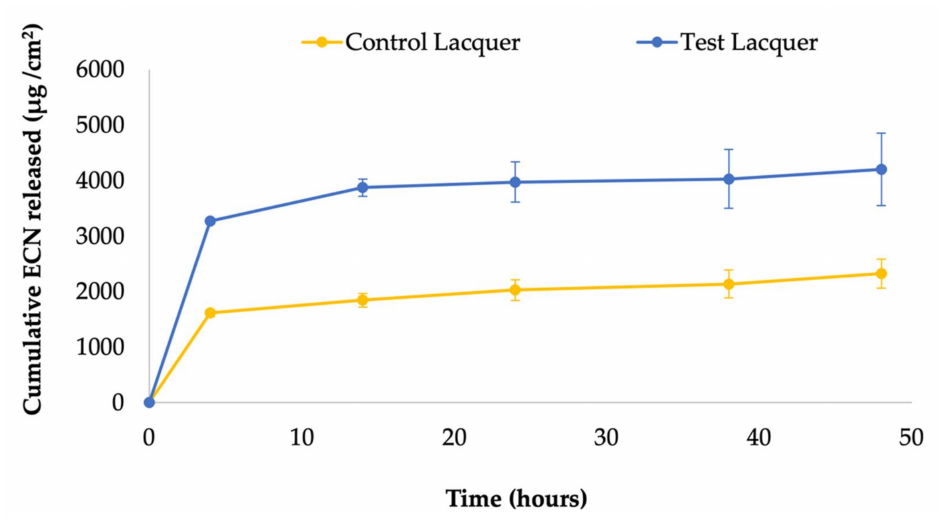
Figure 3. In vitro drug release studies showing cumulative amount of econazole nitrate released from the test and control lacquers across a unit area of the permeation membrane over time, reported as mean ± SD; n = 4 for test lacquer and n = 3 for control